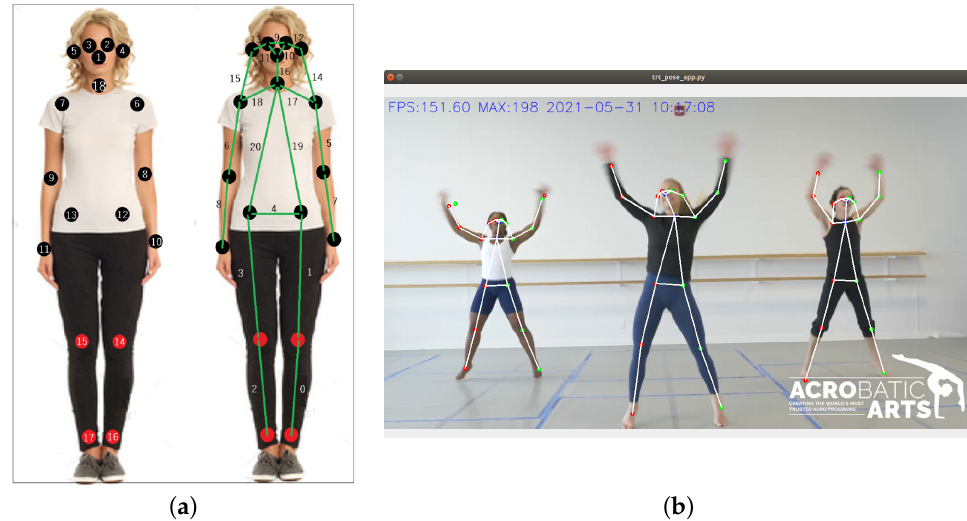
Figure 3. Output of the first subsystem: ( a ) structure and location of the skeleton’s keypoints that represent the joints; ( b ) execution